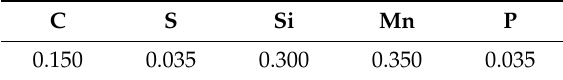
Figure 1. The finite element simulation and the mill of cold roll forming.